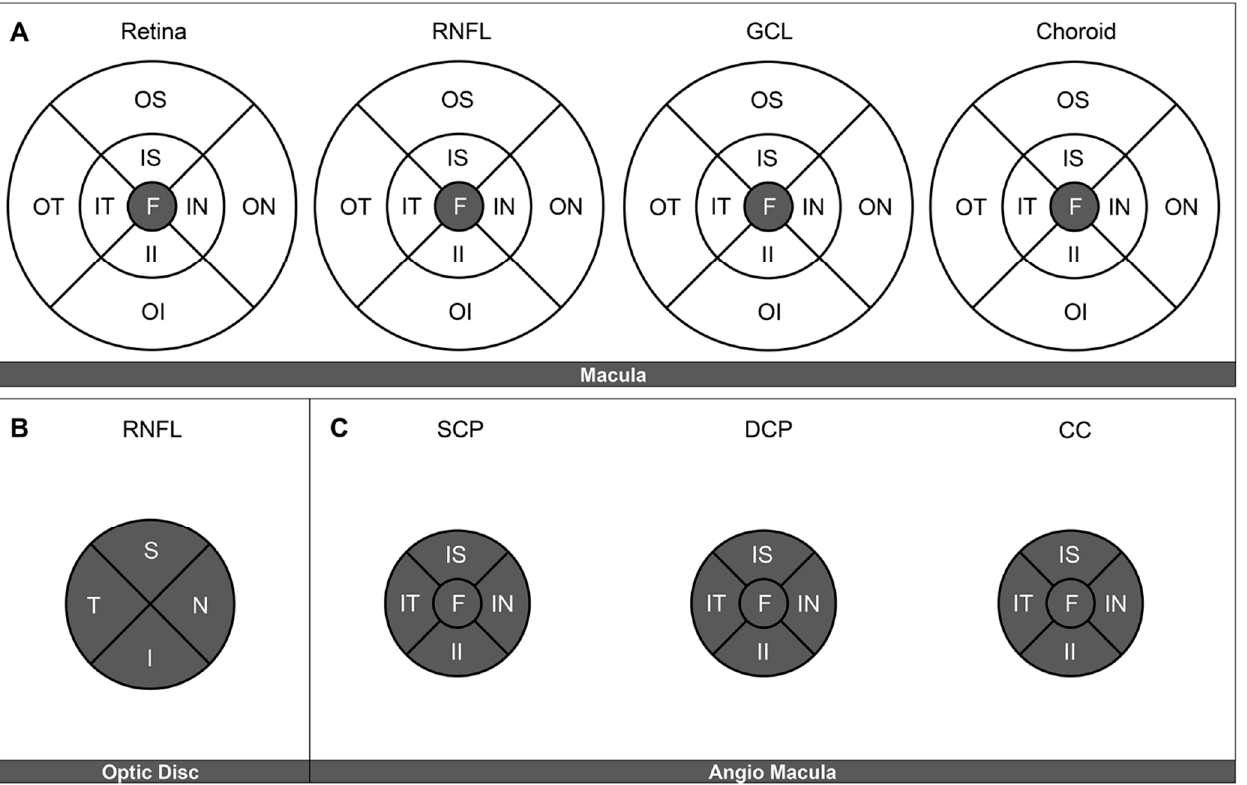
Figure 2. Regions of interest in the macula, defined by the early treatment diabetic retinopathy (ETDRS) grid subfields. The evaluated fields on each of the structural optical coherence tomography (OCT) and OCT angiography (OCTA) are presented in gray ( A ). Structural OCT, macula. Central ETDRS subfield measurements of foveal, retinal nerve fiber layer (RNFL), ganglion cell layer (GCL), and choroid thickness, respectively ( B ). Structural OCT, optic nerve head. Four quadrants ( C ). OCTA, central and inner ring ETDRS subfields. Vessel density measurements were obtained in the superficial capillary plexus (SCP), deep capillary plexus (DCP), and choriocapillaris (CC) layers. F: fovea. IS: inner superior. IN: inner nasal. II: inner inferior. IT: inner temporal. OS: outer superior. ON: outer nasal. OI: outer inferior. OT: outer temporal. S: superior. N: nasal. I: inferior. T: temporal.